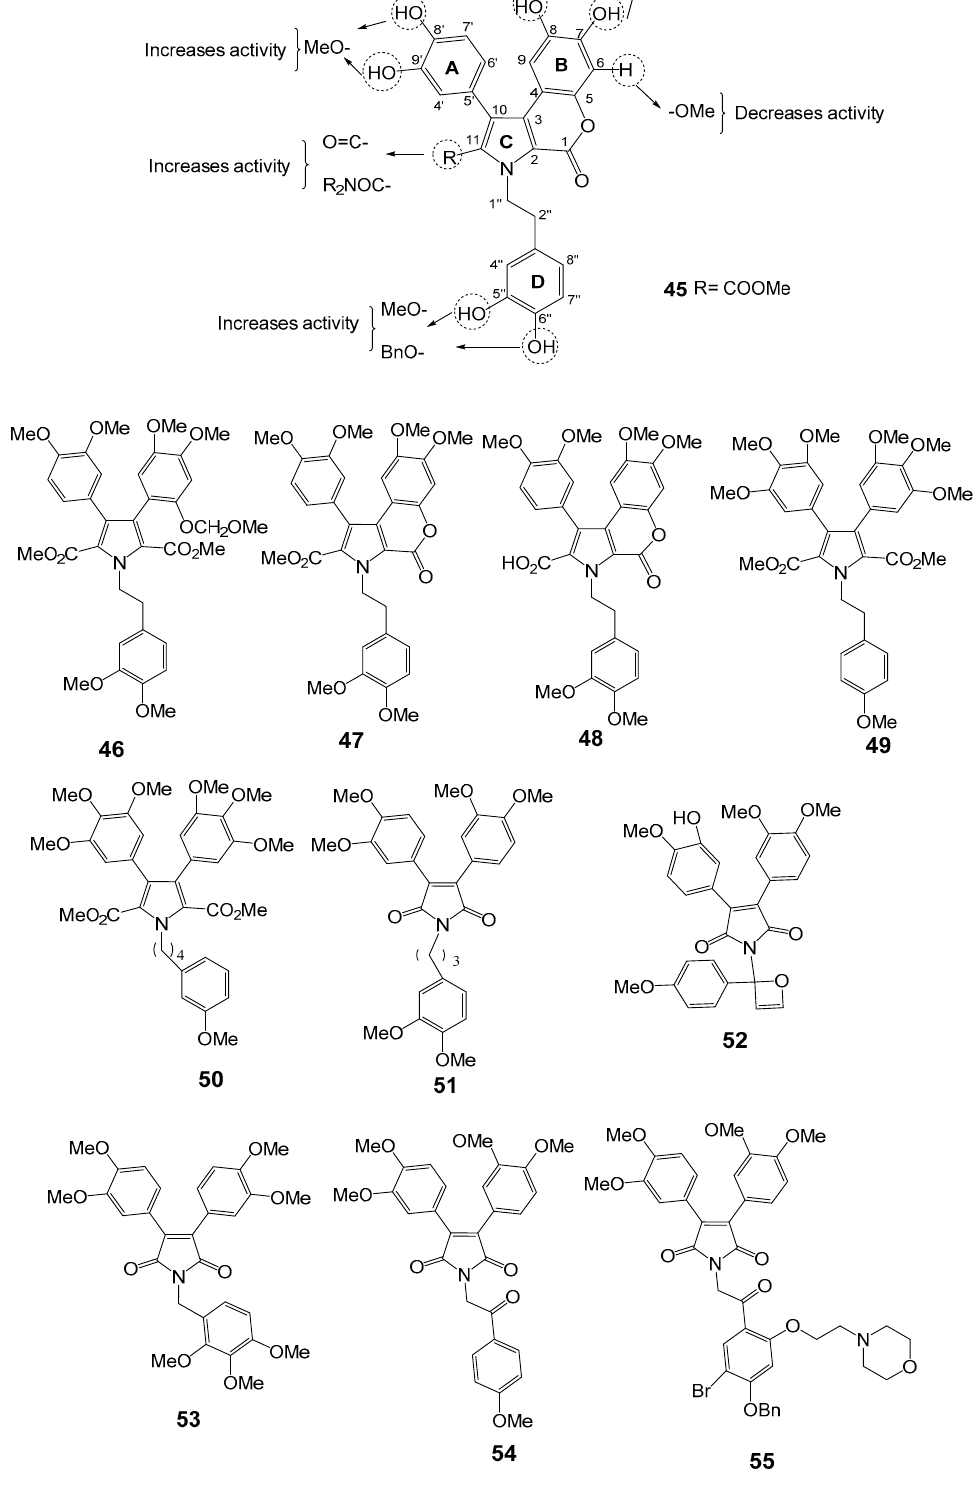
Figure 9. Structures of ningalin B ( 45 ), analogs 46 – 55 , and SAR studies for P-gp modulation.